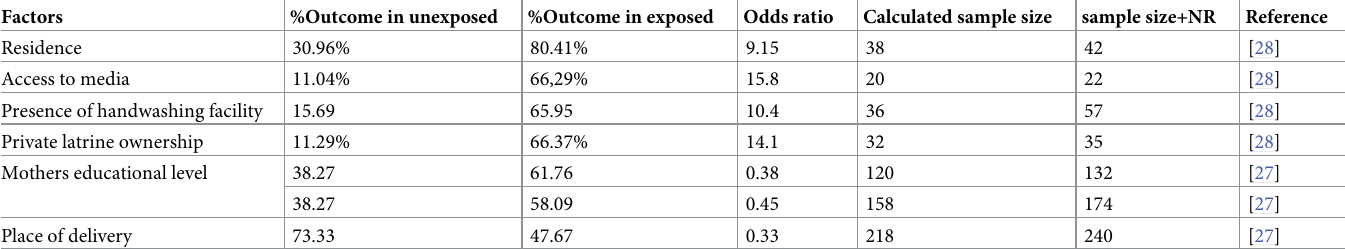
Table 1. Sample size for second